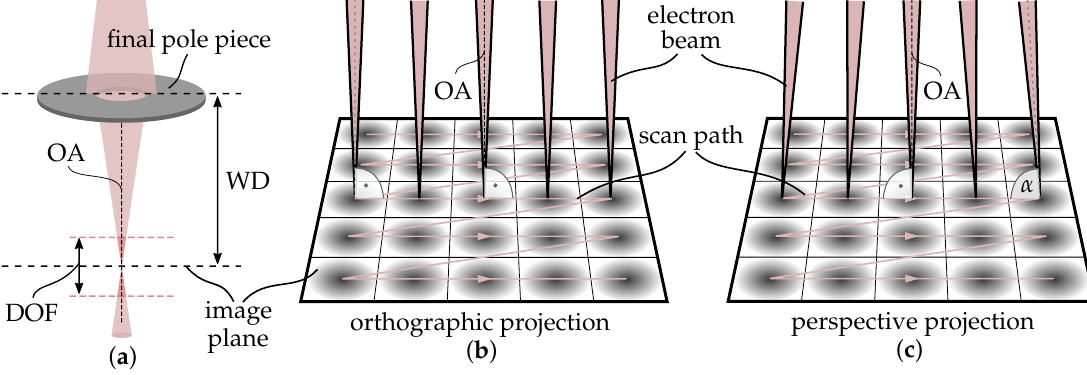
Figure 2. ( a ) Illustration of the working distance (WD) of a scanning electron microscope (SEM), its depth of field (DOF) and the optical axis (OA). ( b ) Ideal orthographic projection of the electron beams. ( c ) Perspective effects diminish for a small field of view as well as large ratios between the WD and depth variation of the scanned area. The smaller the field of view, the closer the angle α gets to